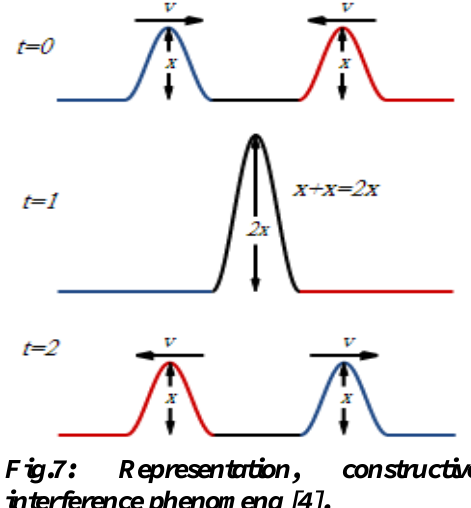
Fig.7: Representation, constructive interference phenomena